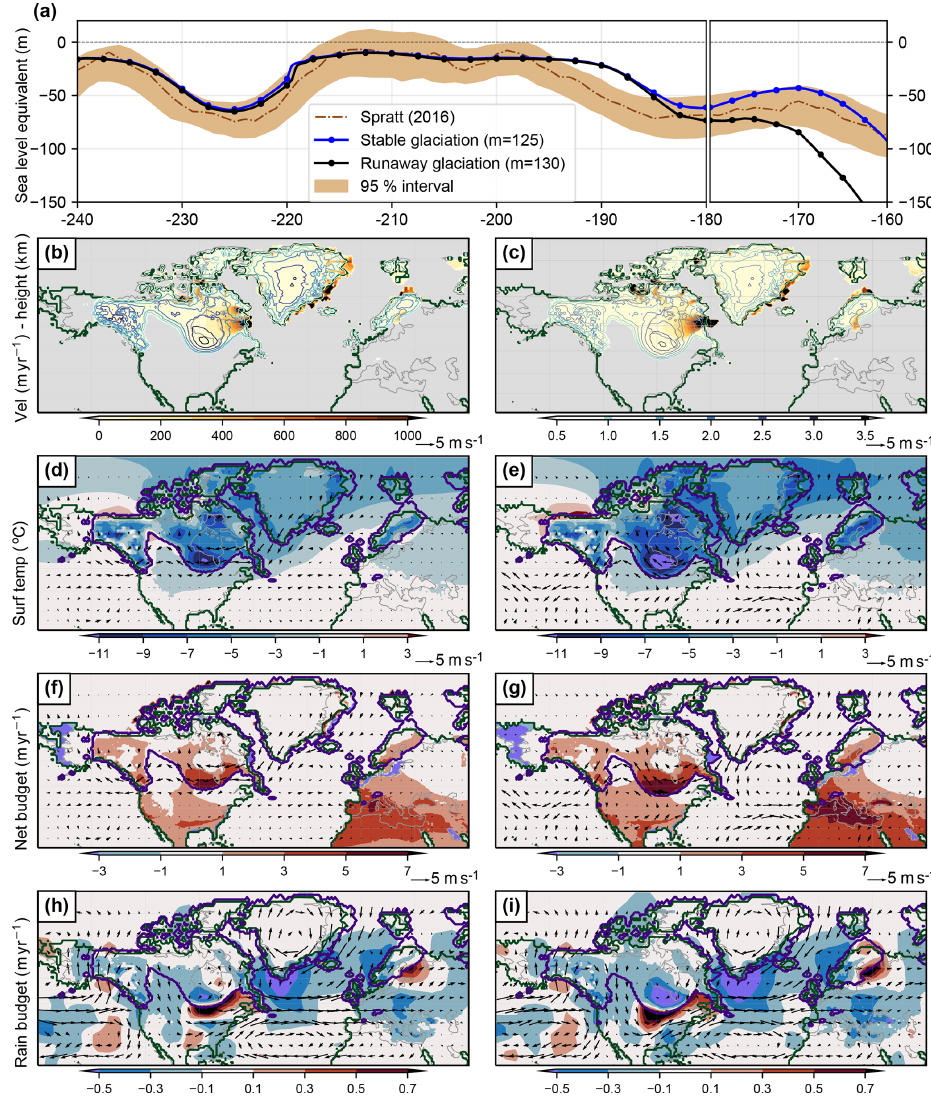
Figure 7. Bifurcation of the system at 180ka while transitioning into MIS 6 over Laurentide. (a) Sea level reconstruction (m) and 95% confi- dence interval of Spratt and Lisiecki (2016) (brown). Total ice volume (in terms of SLE, m) from two ensemble members of LOVECLIP, one that leads to a stable glacial inception (blue; α = 2, m = 125Wm − 2 ) and another into a runaway glaciation (black; α = 2, m = 130Wm − 2 ). Climate and ice sheet variables at 180ka from the stable glaciation on the left column ( b , d , f , and h ) and runaway glaciation on the right ( c , e , g , and i ). (b, c) Basal ice velocity (solid colors; myr − 1 ) overlaid with ice thickness (colored contours; km) and the grounding line (solid green lines). (d, e) Surface temperature anomalies ( ◦ C) overlaid with anomalous wind vectors at 800hPa (ms − 1 ). (f, g) Net mass balance anomalies (myr − 1 ) overlaid with anomalous winds (ms − 1 ). (h, i) Rainfall anomalies (myr − 1 ) overlaid with absolute winds (ms − 1 ). The purple contours in (d) to (i) mark the boundaries of the ice sheets from each run (stable for left and runaway for right). Anomalies here are with respect to the initial condition at 240ka. Anomalies over the Eurasian and Siberian ice sheets are small and not